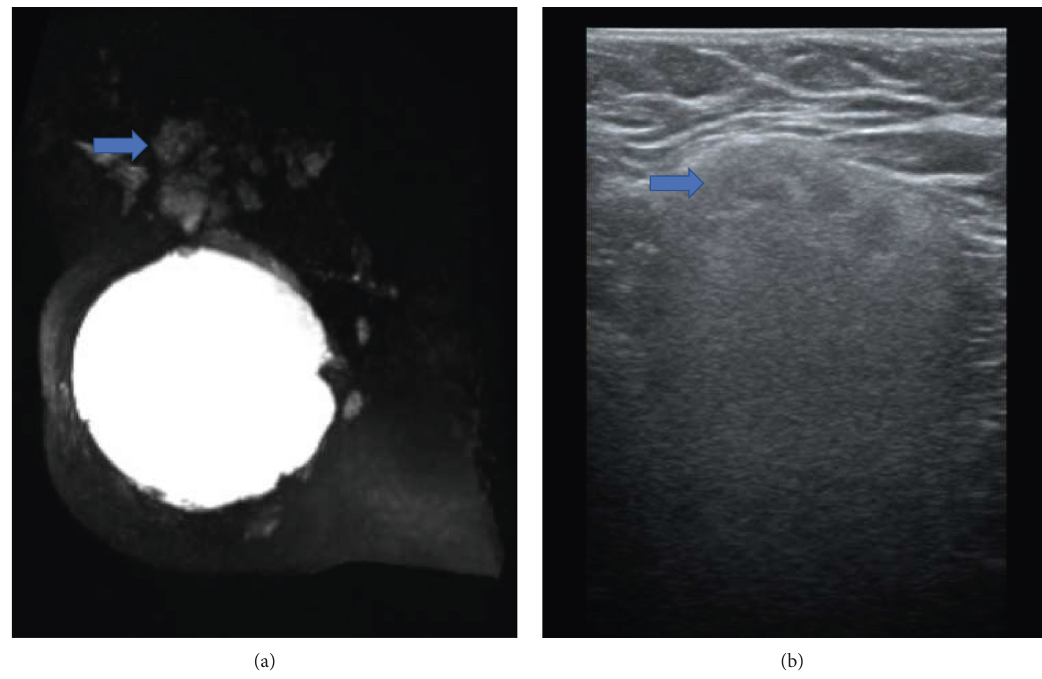
Figure 10: (a and b). 62-year-old women with silicone for 11 years. The MRI (a) shows intact silicone implant in the right breast associated with siliconomas in axillary lymph nodes. The axillary ultrasound (b) confirms the siliconoma as a mass with snowstorm